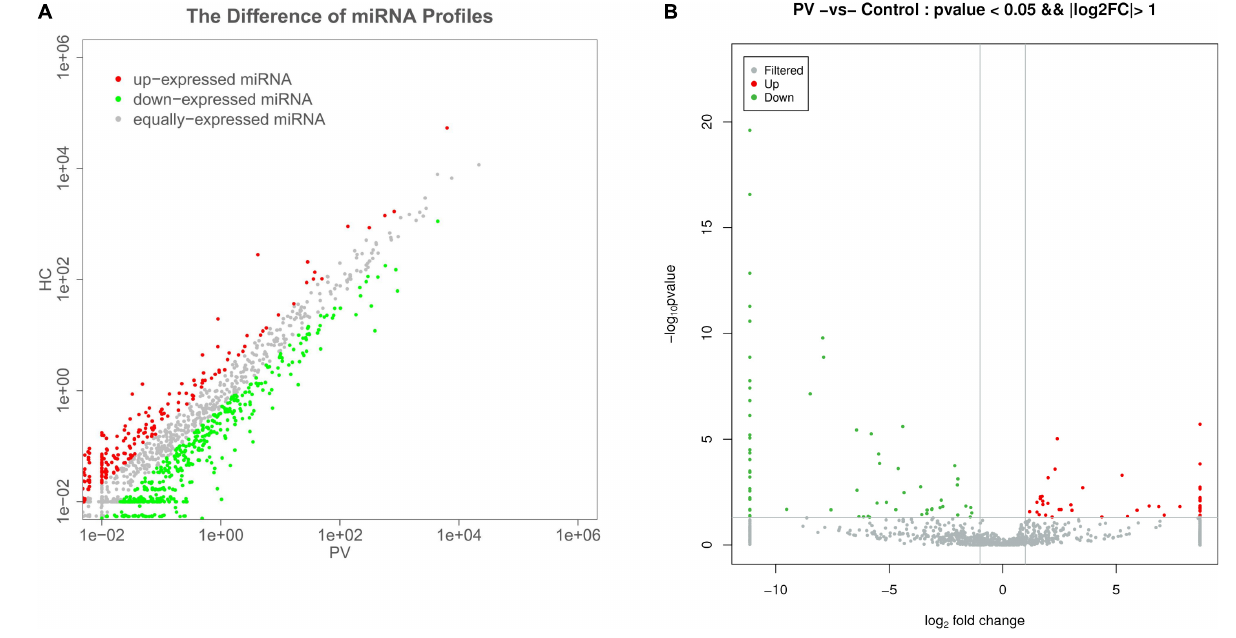
Frontiers in Medicine |